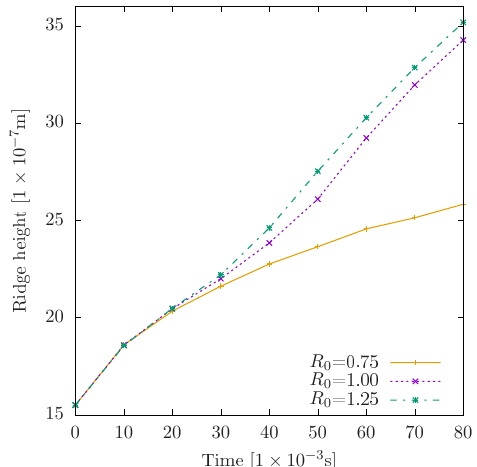
Figure 4. Ridge height as a function of simulation time for different groove shapes (different R 0 ). An increase in the ratio R 0 assists the morphological development of ridge-shaped instability near the grain boundary groove